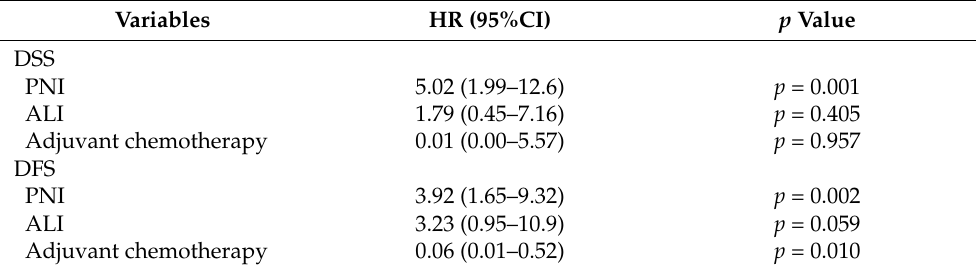
Table 2. Multivariate analysis for disease-specific survival and disease-free survival in 166 patients with T2N0 OSCC.